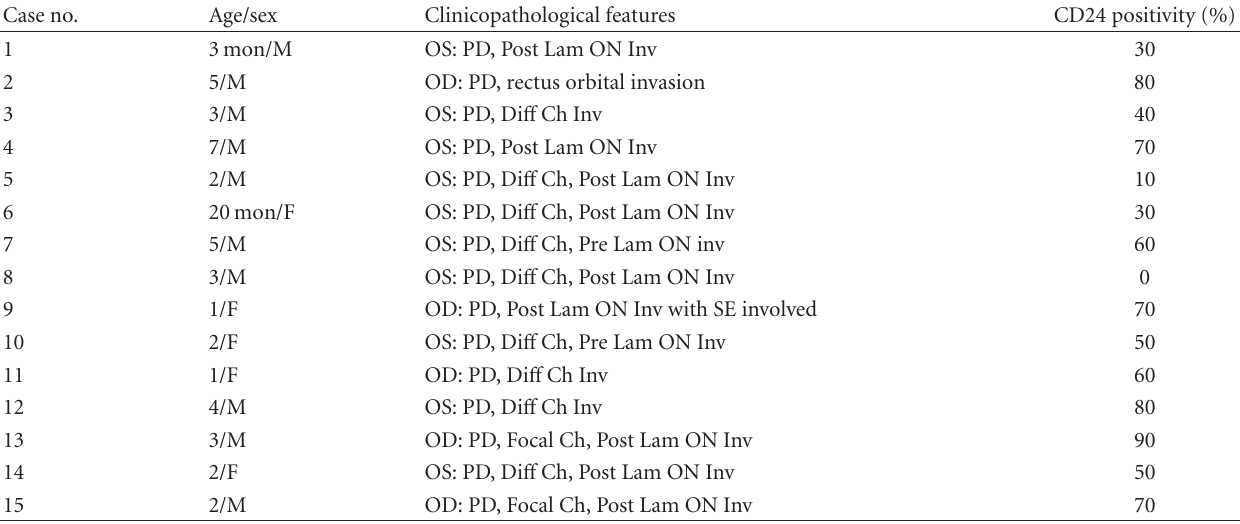
Table 2: The expression of CD24 protein and clinicopathological features of retinoblastoma tissues with high risk of extraocular relapse. Case